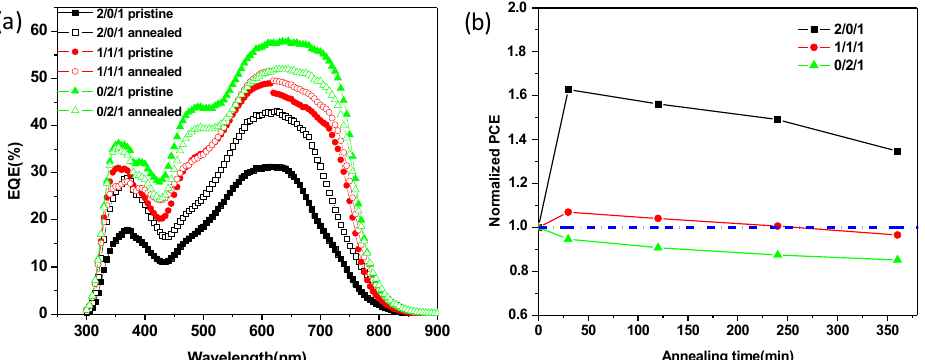
Figure 4. ( a ) EQE curves of devices with and without thermal annealing based on TQ1 / PCE10 / PNDI-T10 blend films with di ff erent blend ratios cast from CF; ( b ) Normalized PCE of devices with di ff erent thermal annealing time.